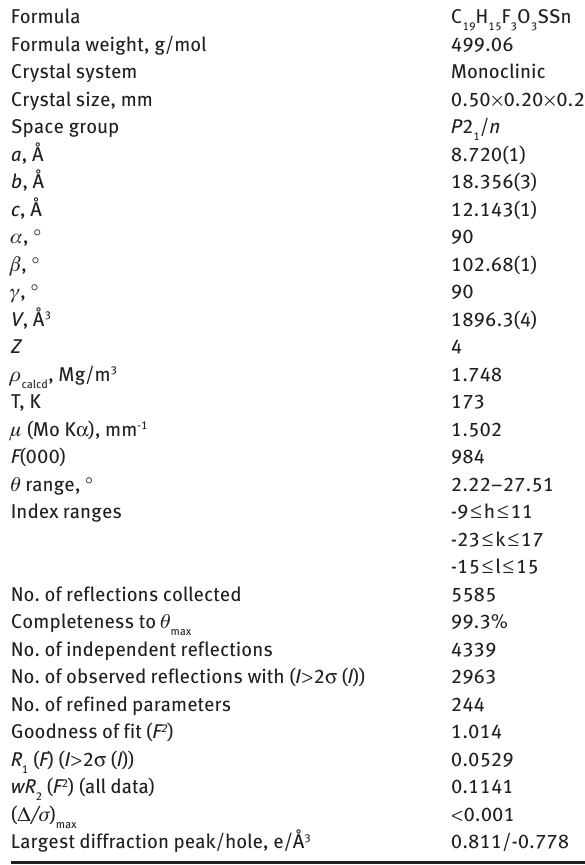
Table 1 Crystal data and structure refinement of Ph